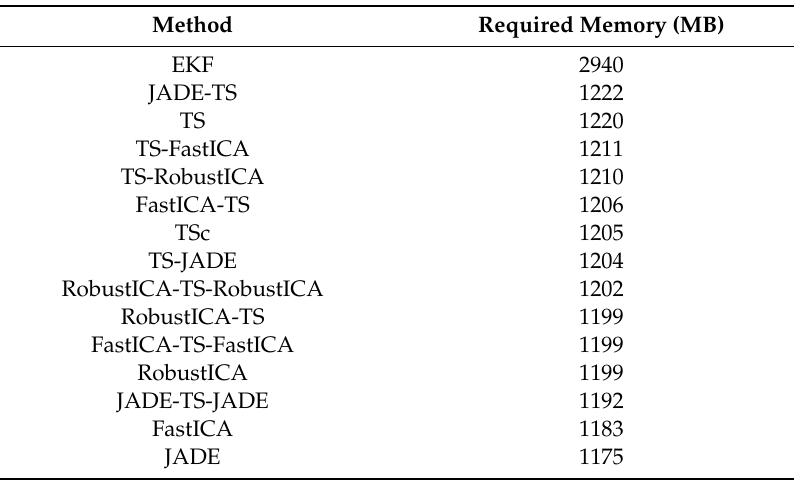
Table 3. Required memory for different methods.